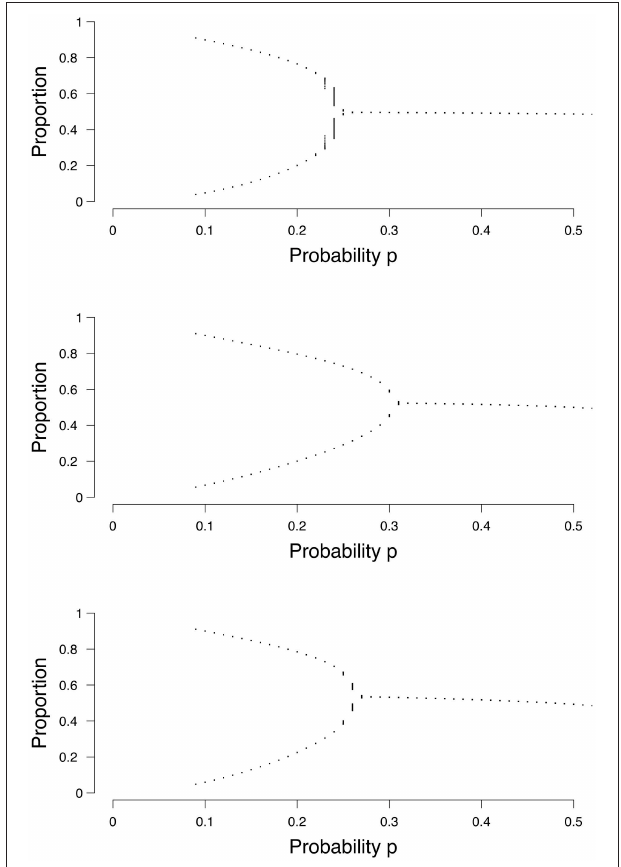
FIGURE 4 | Examples of bifurcation diagrams for a grid (Top) , a random graph ( Middle ; p ( e ) = 0.1) and a small-world graph ( Lower ; p ( w ) = 0.1). The x -axis denotes the probability p for a node to become active. The y -axis denotes the proportion of nodes in the system that are